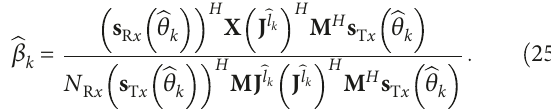
Algorithm 1 summarizes the phase estimation process for the